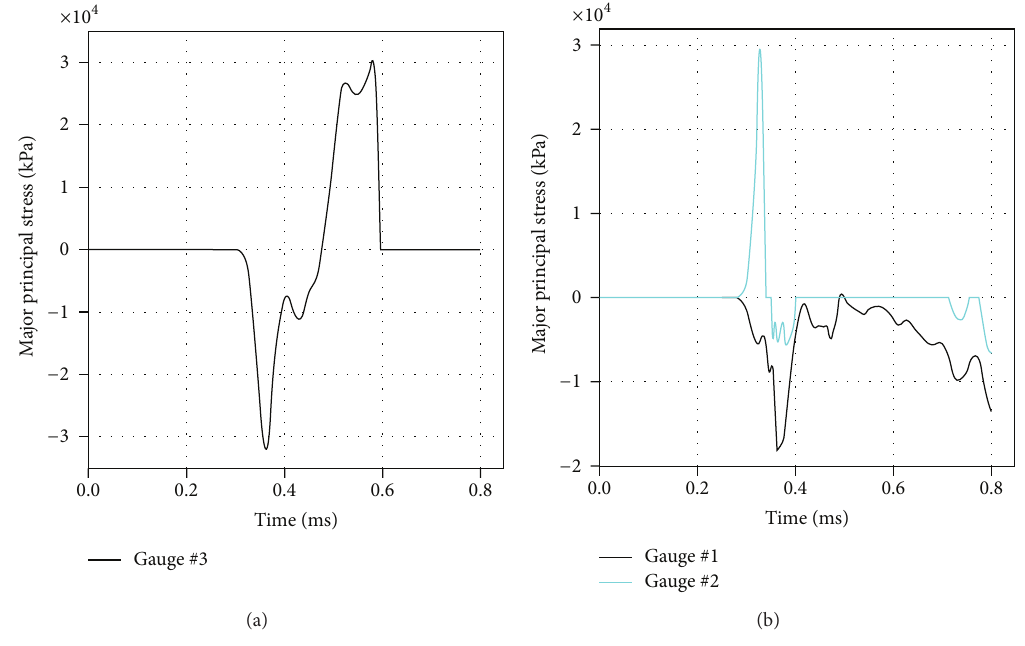
Figure 8: Time history curves of major principal stress at gauges for incident angle of (a) 0 ∘ and (b) 45 ∘ .